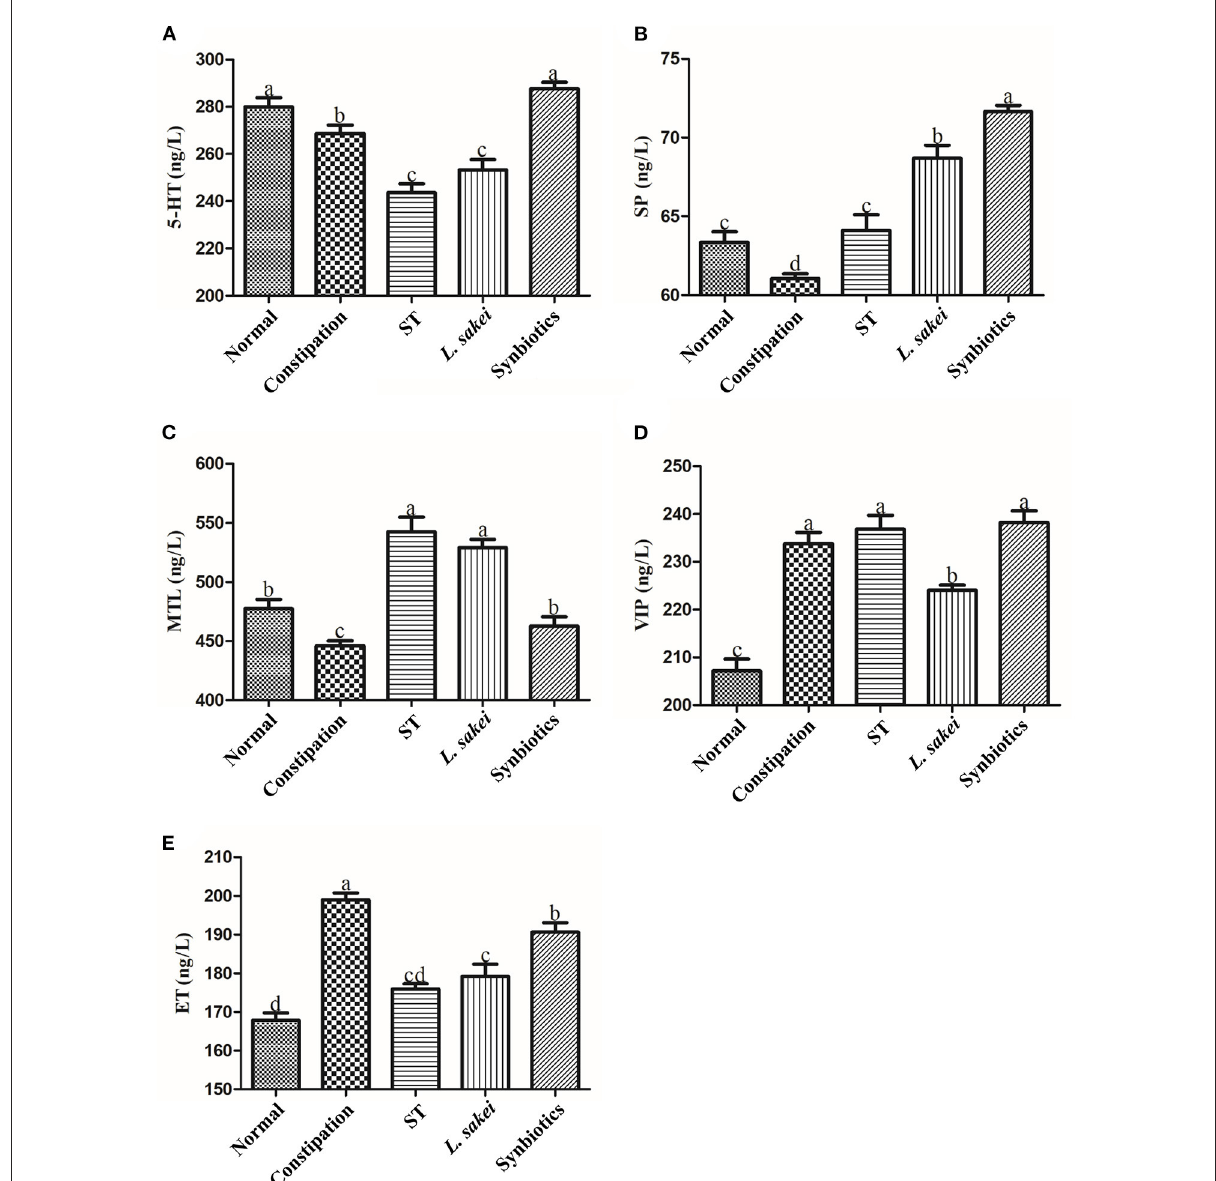
FIGURE4 Effects of ST or L. sakei alone or combined on intestinal hormone levels in mice. (A) 5-HT level; (B) SP level; (C) MTL level; (D) VIP level; (E) ET level. 5-HT, 5-hydroxytryptamine; SP, substance P; MTL, motilin; VIP, vasoactive intestinal peptide; ET, endothelin. Statistical analysis was conducted using One-way ANOVA followed by Tukey’s multiple comparisons test for each group. Bars bearing different letters indicate a significant difference, P <